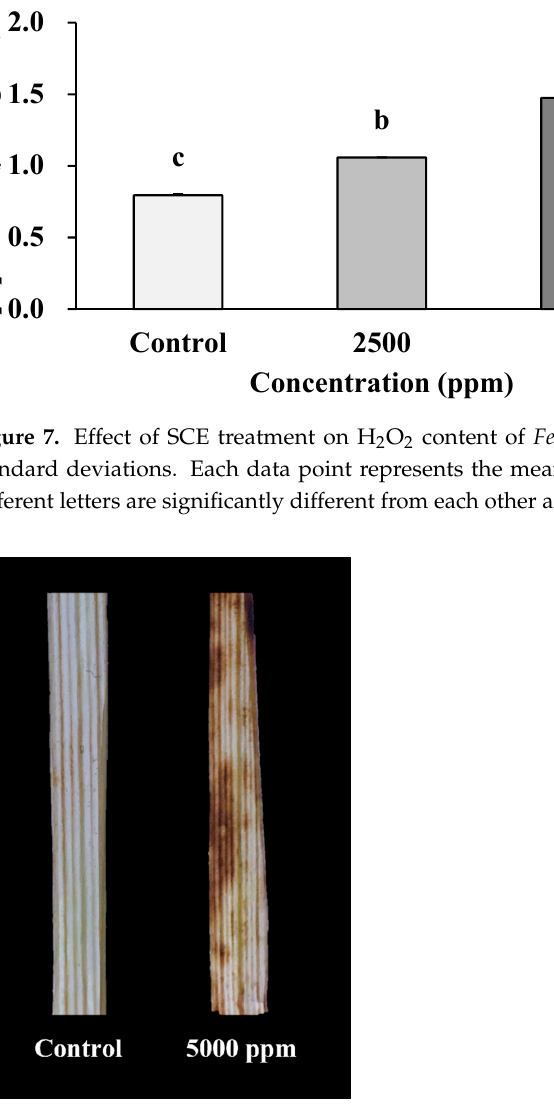
Figure 6. Effect of SCE treatment on the O 2 − content of Festuca arundinacea . Error bars represent standard deviations. Each data point represents the mean of at least eight replications. Bars with different letters are significantly different from each other at p ≤ 0.05.